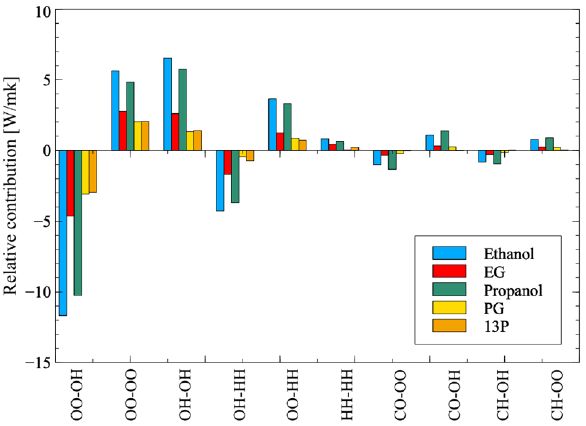
Figure 7. The relative contribution of the top 10 atomic-correlation contributors (out of a total of 55) to the thermal conductivity of each molecule (Eq. 13). Contributors are ordered by magnitude, with positive and negative values preserved in the graph. For each molecule, the sum of all 55 relative contributions will add to one. Correlations between oxygen (O), hydrogen attached to oxygen (H) and carbon (C) atoms are represented on the x-axis. Hydrogen atoms attached to carbon atoms do not feature in the top 10 contributors and are therefore not shown. For example, CO–OH represents the contribution of correlation of flux between